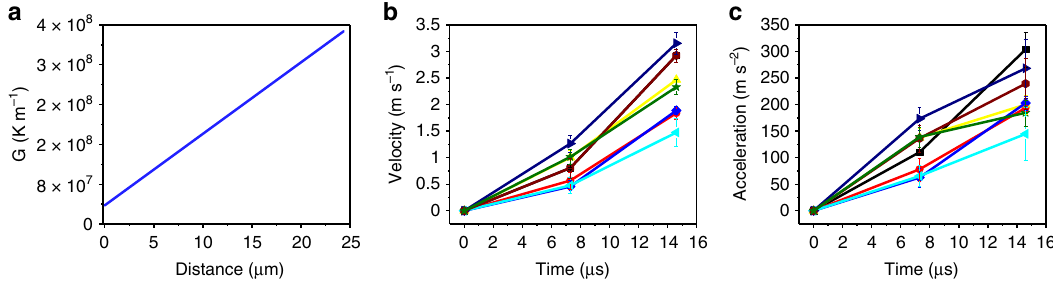
Fig. 5 Increase of acceleration as pores move toward depression zone wall. a Variation of temperature gradient, G , from the melting front (solid-liquid interface during melting) to the depression zone wall (indicated by the white arrow in Fig. 3d). The temperature gradient increases towards the depression zone wall. b Velocity, as a function of time, as pores move toward depression zone wall. c Acceleration, as a function of time, as pores move toward depression zone wall. The acceleration increases as pores move toward the depression zone wall. Error bars represent standard deviation (s.d.); The data in b and c are collected during laser melting of an AlSi10Mg bare plate (laser power of 310 W, scan speed of 1 m s − 1 )